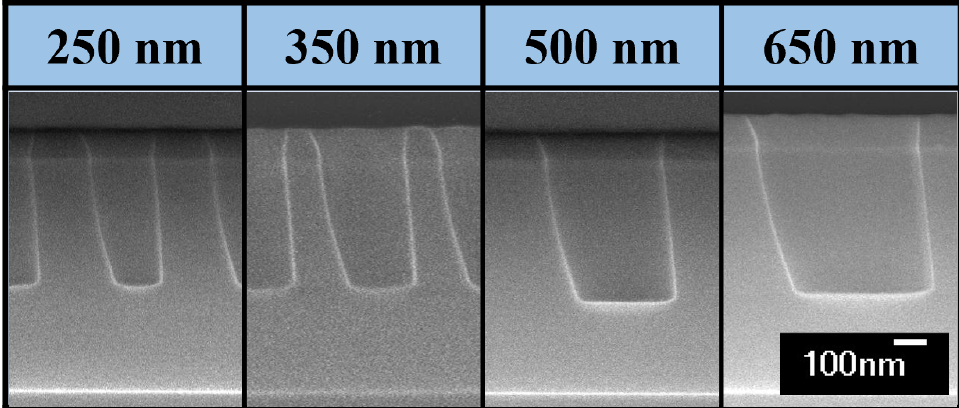
Figure 7. Cross-sectional SEM images of contact holes varying a diameter in set point 1 and 3.0 mm wafer height.